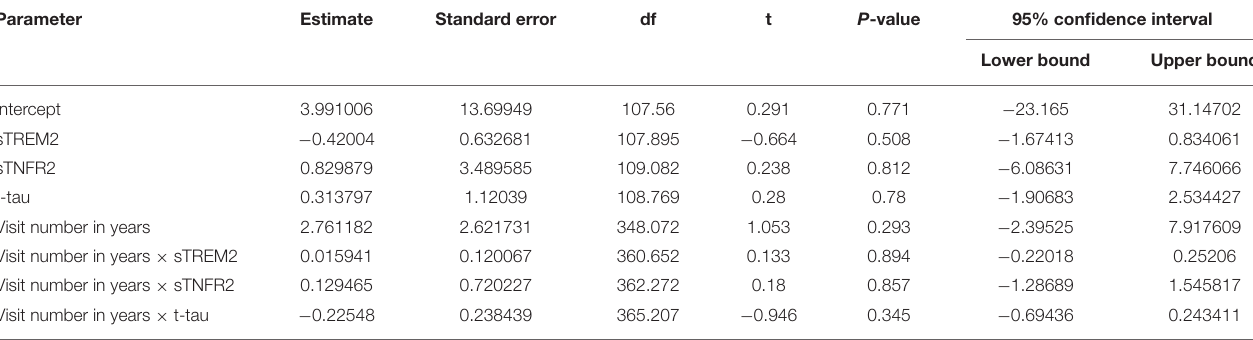
TABLE 6 | Key results of the linear mixed-effects regression model with CDR-SB as the dependent variable among participants with A + T + mild cognitive impairment from the Alzheimer’s Disease Neuroimaging Initiative cohort (Model 3). Parameter